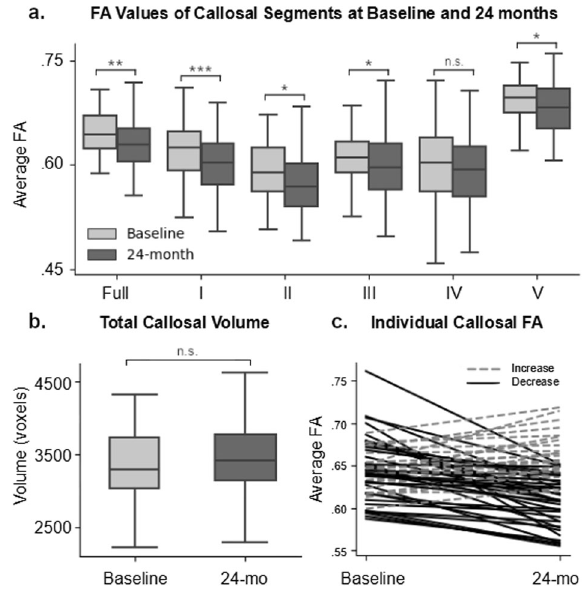
Fig. 2 Longitudinal analysis of individually-based CC ROI ’ s. a This bar chart shows the FA values for the full CC ROI and each callosal segment at the baseline (light gray) and 24-month (dark gray) follow-up time-points. Error bars displayed are 95% con fi dence intervals. b Averaged callosal volume indexed in number of voxels at the baseline and 24-month follow-up time-points. Voxels are 2 mm 3 . c Individual FA changes for the full corpus callosum from baseline to 24-month follow-up. Each line is a subject, with dashed and solid